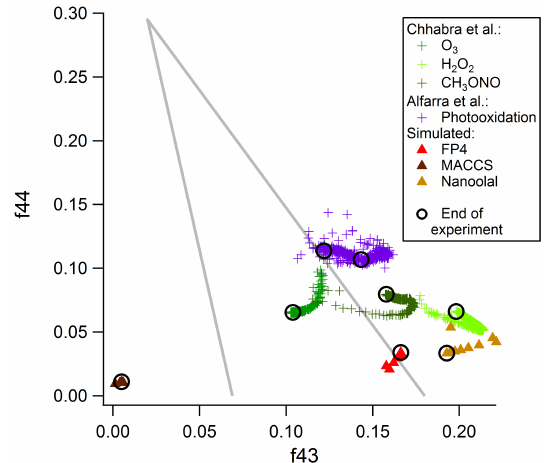
Figure 9. “Triangle plot” comparing predicted f 44 and f 43 values for the Valorso et al. (2011) GECKO-A α -pinene SOA simulation with chamber experiments. The Chhabra et al. (2011) data compare different oxidant systems and are taken from Fig. 2a of that paper. The chronological final points in each dataset are